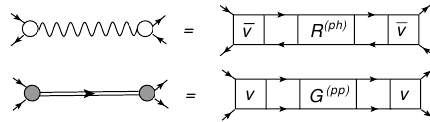
Figure 2. Diagrammatic mapping of the EOM to the PVC-TBA. Empty and filled circles denote the coupling vertices of the nor- mal and pairing phonons, respectively, and the wiggly and dou- ble lines their propagators. R ( ph ) and G ( pp ) are the particle-hole response function and the particle-particle Green function, re- spectively. t (cid:29) ). ( t Figure 1. The components of the dynamical kernel K ( r ) 12 , 1 (cid:29) 2 (cid:29) − Straight solid lines stand for fermionic propagators, the square blocks denote the antisymmetrized nucleon-nucleon interaction ¯ v , and the rectangular blocks G (4) correspond to the two-particle- two-hole Green function (7). Figure 3. Dynamical kernel of the conventional PVC-TBA (top) and generalized EOM-TBA (bottom).